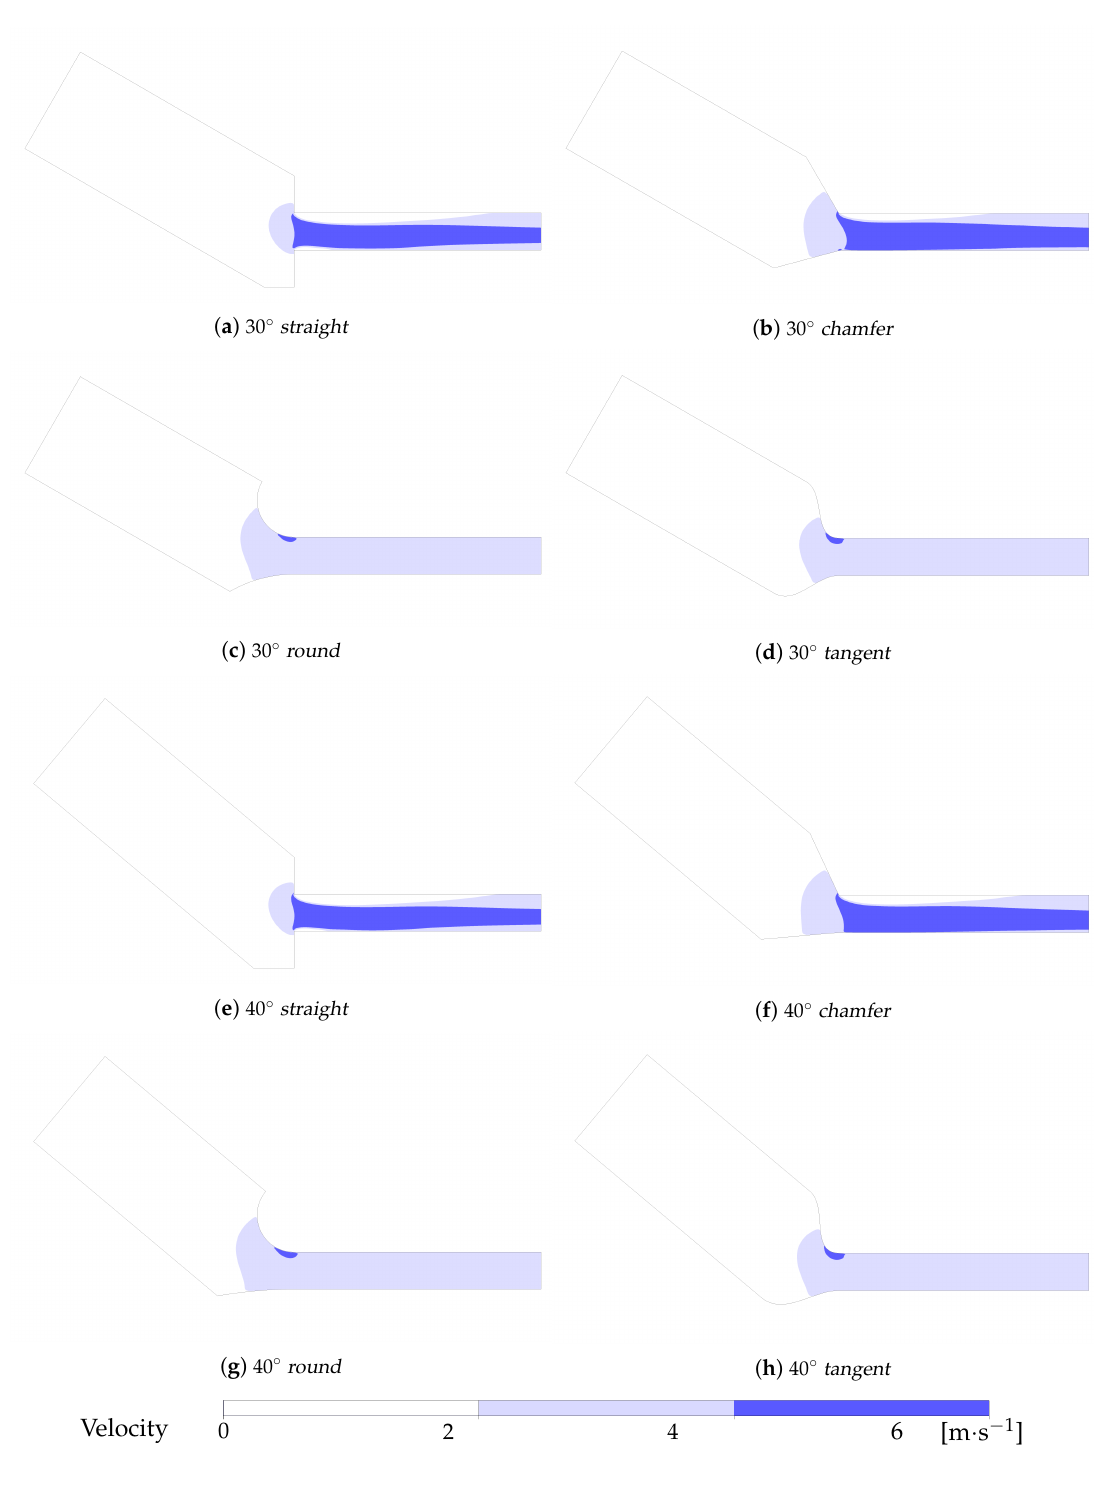
Figure A3. Velocity Contours for 30 ◦ and 40 ◦